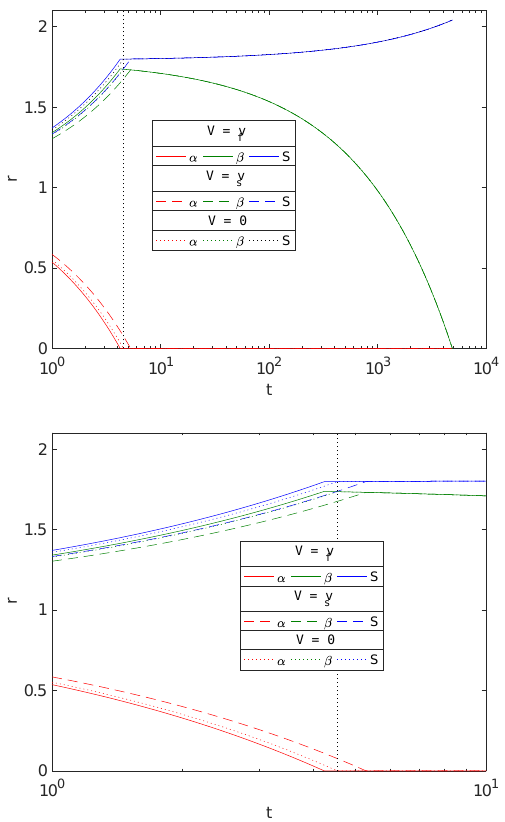
Figure 9. Plots of the evolution of the dimensionsionless variables α , β and S resulting from three choices of fluid phase advection velocity, V i , namely V i = v f (as proposed in the current model, i solid lines), V i = 0 (dotted) and V i = v s (as used in [16], dashed). The left plot shows the full evolution i of the interfaces and the right plot shows the results around t = T α . The results are using cylindrical geometry, with ε 1 = 0.6, ε 2 = 0.4 and parameters in Table 4 and S 0 =